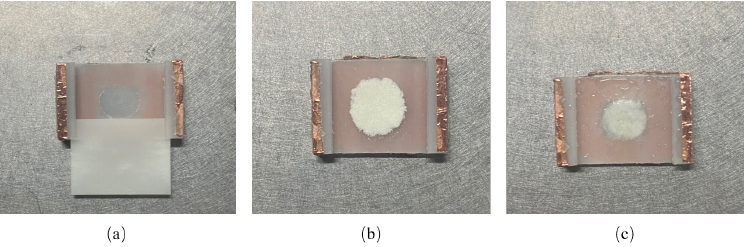
Figure 1. Preparation process of L-Arginine suspension. ( a ) The empty sample cell; ( b ) The sample cell with solid L-arginine power; ( c ) The sample cell with L-arginine